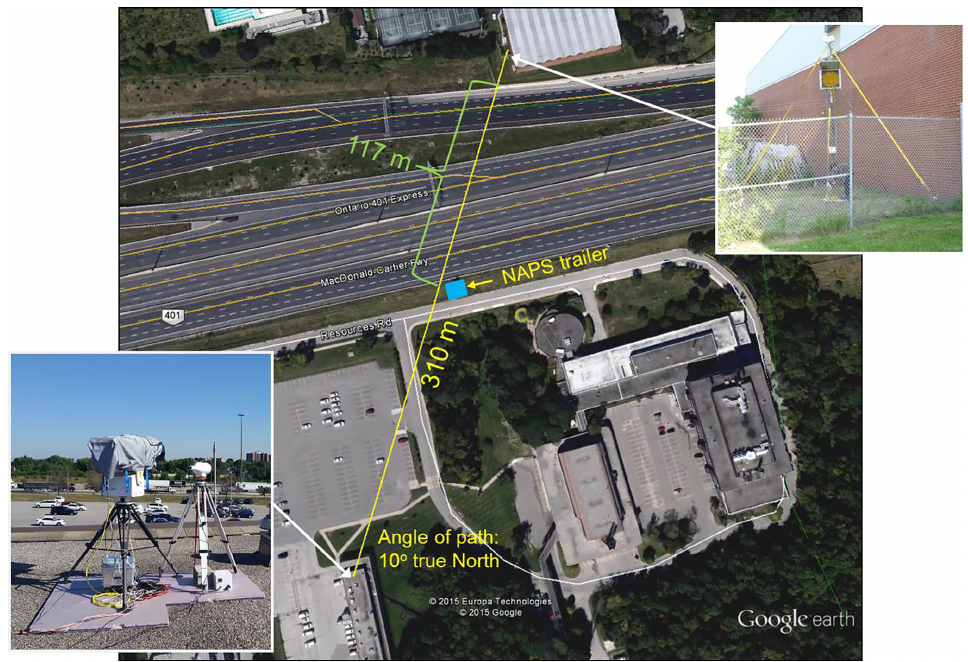
Figure 1. Setup of the FTIR spectrometer, scintillometer (see Sect. 2.2), and the NAPS trailer near Highway 401.